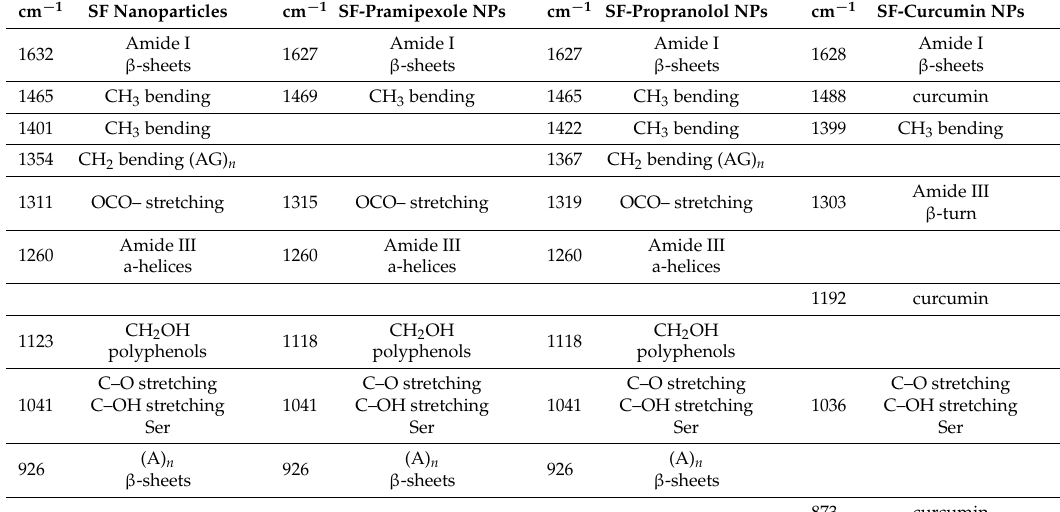
Table 2. Assignments of the FTIR bands of silk fibroin nanoparticles and drug-encapsulated silk fibroin nanoparticles.